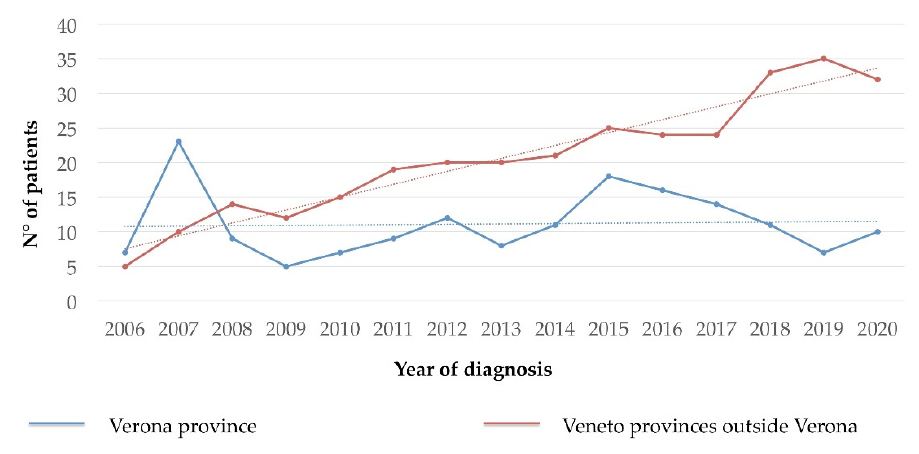
Figure 1. Number of new diagnoses of clonal mast cell disorders (all types) per year in the population residing in the province of Verona and in the other provinces of the Veneto region (excluding Verona).